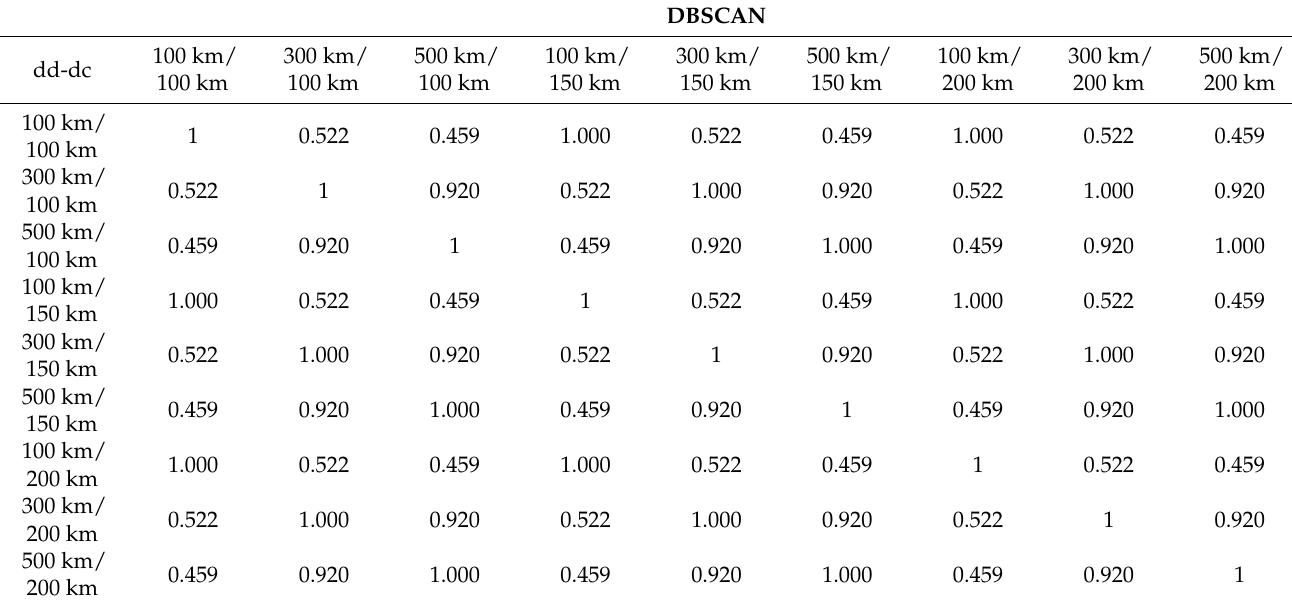
Table 3. Kendall rank correlation index between the maps obtained by the DBSCAN analysis. dd = maximum diameter of the distribution of the species; dc = distance between the